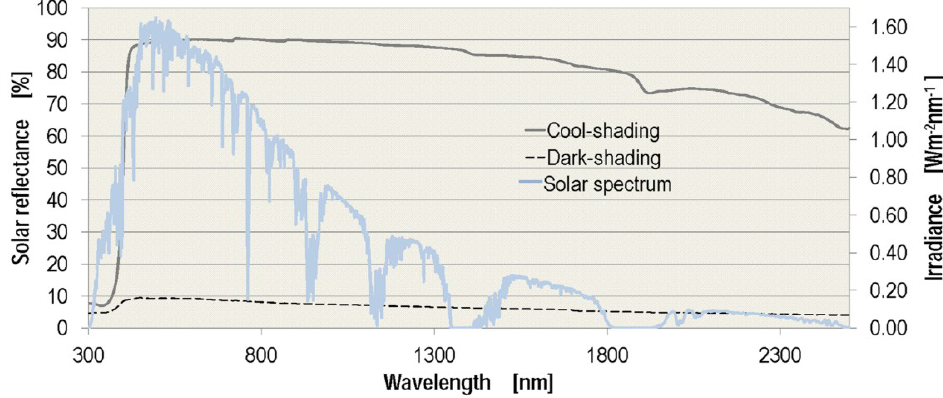
Figure 2. Spectrophotometer measurement results of solar reflectance of Cool Shading vs. Dark